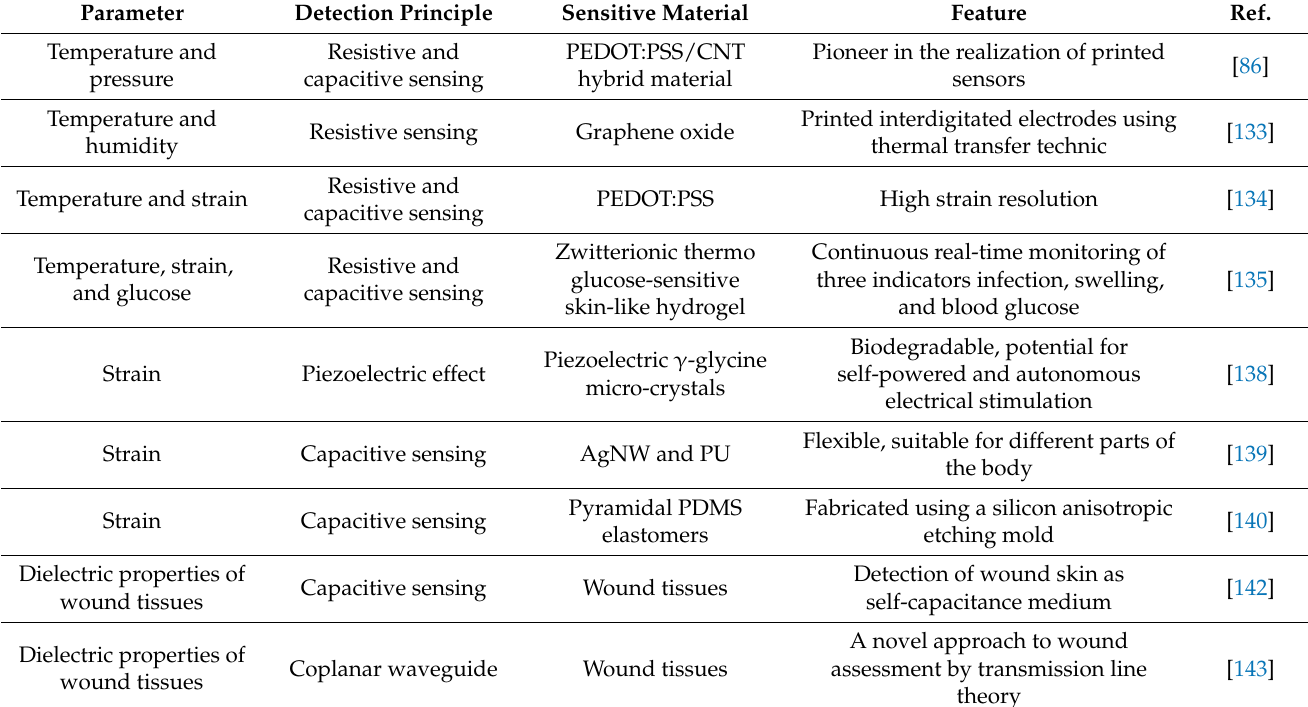
Table 2. The detection principles, sensitive materials, and features of the flexible wearable sensors for wound detection with other electrical detection principles mentioned in this